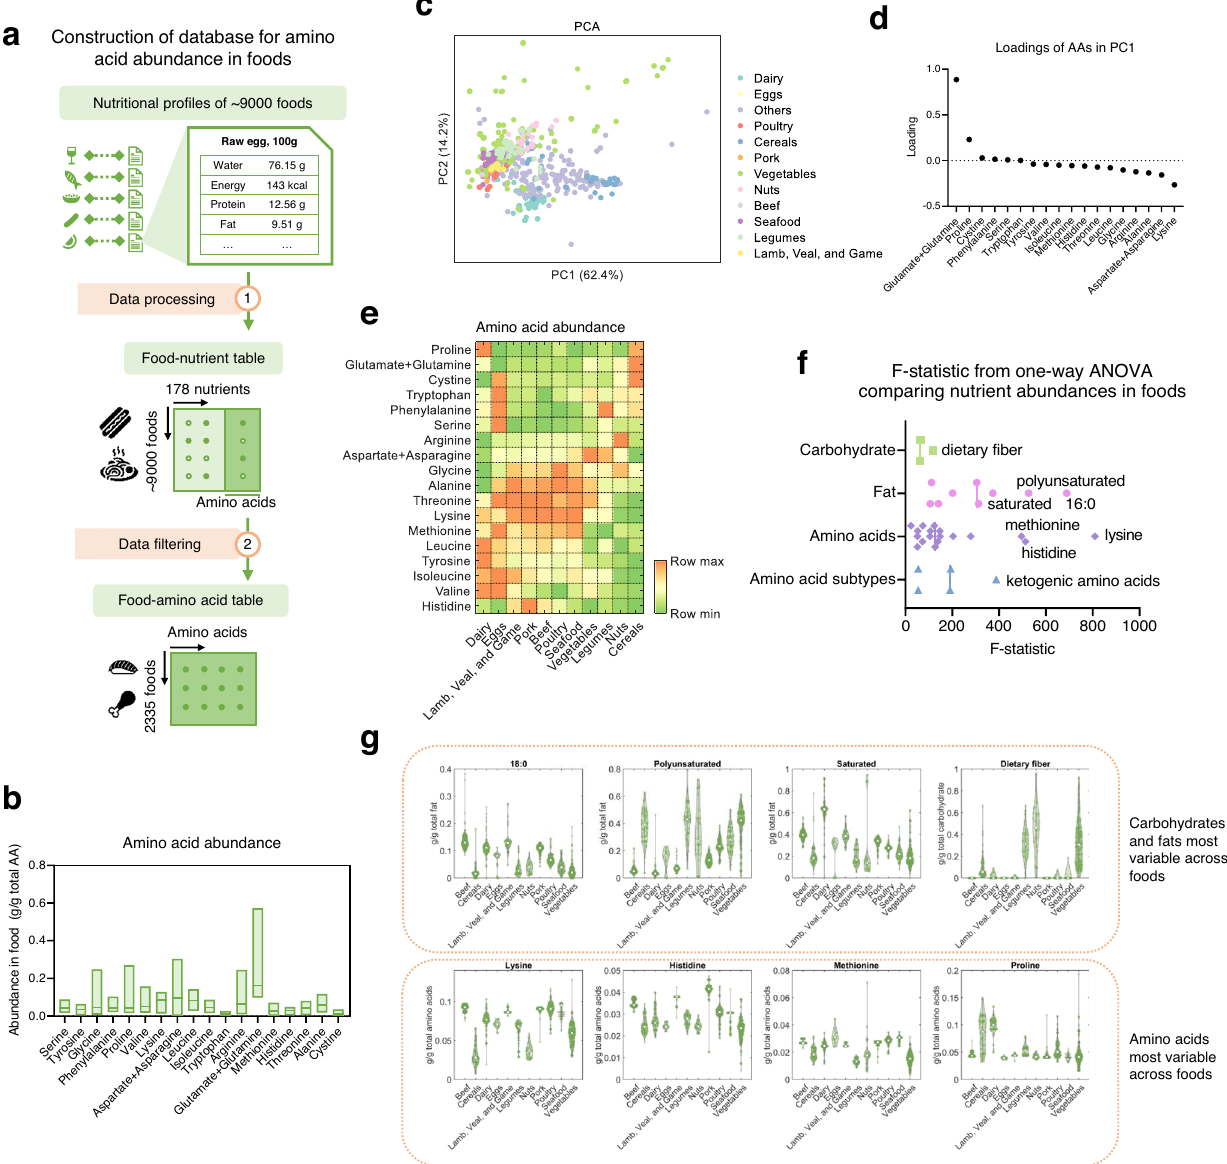
Fig.1|Aminoacidlandscapeofhumanfoods.a Work fl owforconstructionofthe database for amino acid abundances in human foods. Food images used with permission from Microsoft. b Ranges of amino acid abundance in human foods. The horizontallinesindicate medianvalues. The upperand lower bounds ofboxes indicatetherangeofdata.n=2335foods. c Principalcomponentsanalysis(PCA)of amino acid pro fi lesinhumanfoods. Each dot represents a food.Colors of the dots indicate different categories of the foods. d Loading of amino acids in the fi rst